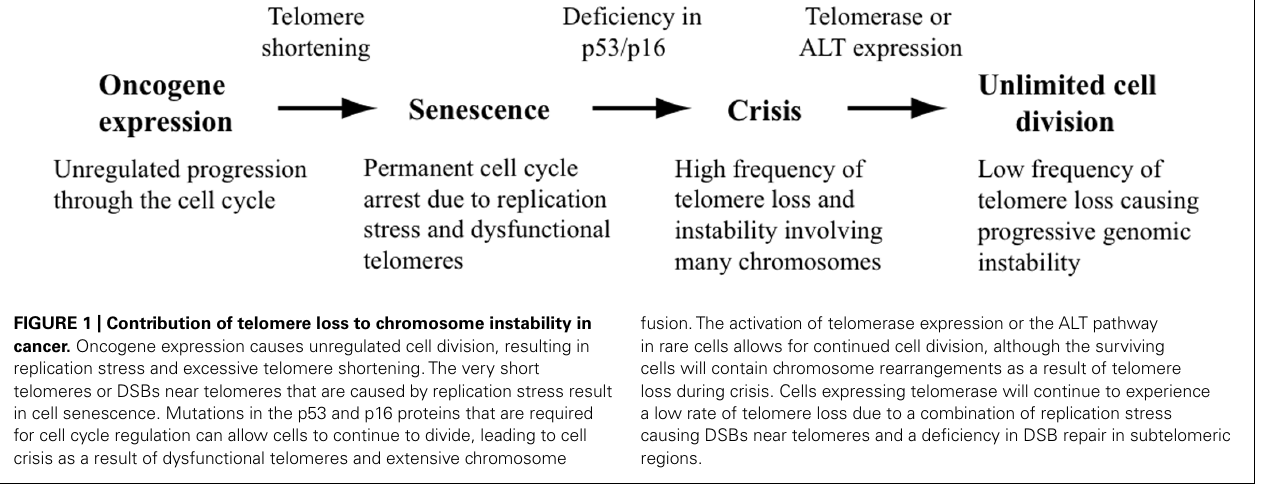
FIGURE 1 | Contribution of telomere loss to chromosome instability in cancer. Oncogene expression causes unregulated cell division, resulting in replication stress and excessive telomere shortening.The very short telomeres or DSBs near telomeres that are caused by replication stress result in cell senescence. Mutations in the p53 and p16 proteins that are required for cell cycle regulation can allow cells to continue to divide, leading to cell crisis as a result of dysfunctional telomeres and extensive chromosome